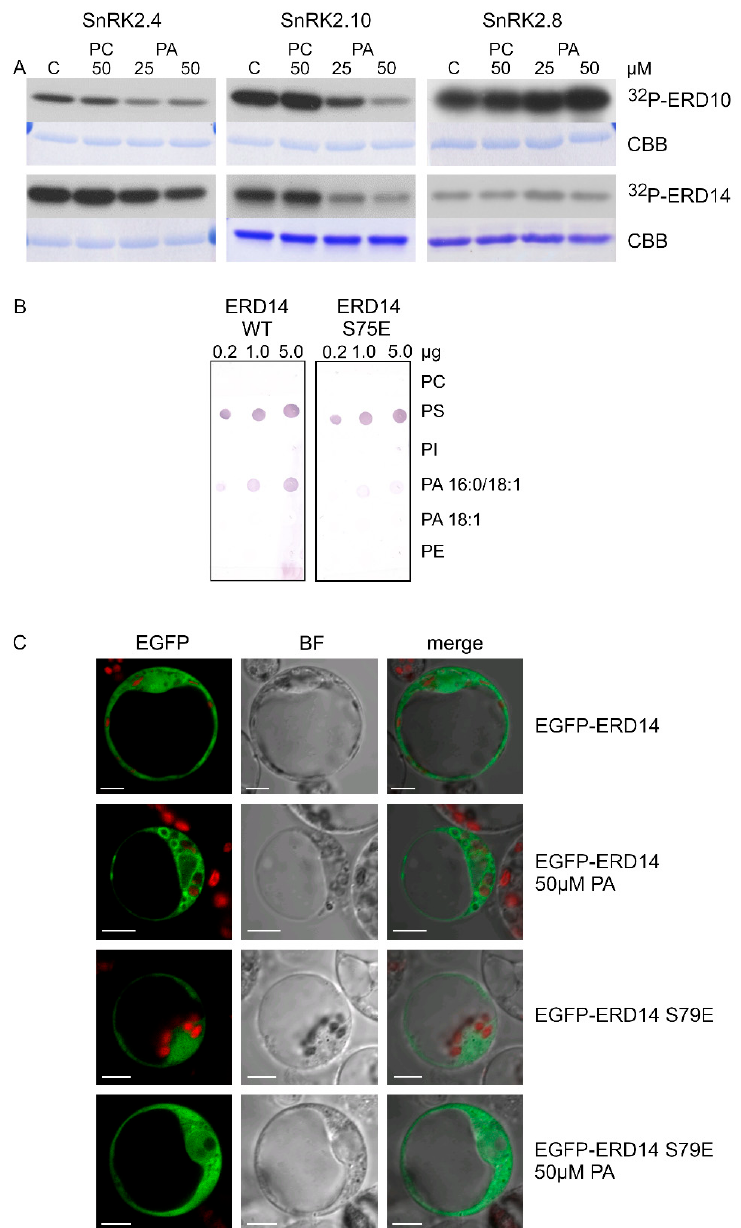
Figure 4. Mutual relationships between PA and phosphorylation and subcellular localization of dehydrins. ( A ) Effect of PA on the phosphorylation of ERD10 and ERD14 by various SnRK2s. Phosphorylation of the dehydrins by the ABA-non-activated SnRK2s SnRK2.4 and SnRK2.10 and the ABA weakly activated SnRK2 SnRK2.8 was analyzed in vitro in the absence or presence of 25 and 50 μ M PA 16:0/18:1 or PC in the reaction mixture. The kinases and dehydrins were produced in Escherichia coli , and purified proteins in fusion with GST were used. Reaction products were separated by SDS-PAGE, and phosphorylation was determined by autoradiography. 32 P-ERD10/ERD14— autoradiography; CBB—Coomassie Brilliant Blue staining. Data represent one of three independent experiments showing similar results. ( B ) Phospholipid binding by ERD14 and ERD14 S79E. Binding of different phospholipids by ERD14 and ERD14 S79E was analyzed using a lipid overlay assay. Nitrocellulose membranes with increasing doses of immobilized phospholipids, as indicated, were